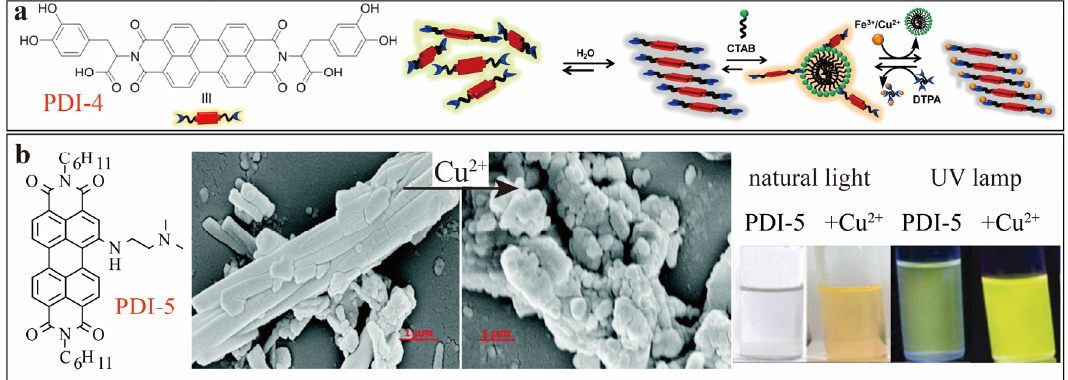
Figure 3. ( a ) Schematic illustration of CTAB and metal ions induced assembly-disassembly process of PDI-4. Reproduced with permission from [10], copyright 2014 American Chemical Society. ( b ) Molecular structures of PDI-5, and the SEM images of their self-assemblies from (10 µM) ACN solution before and after adding Cu(ClO 4 ) 2 , as well as photos of color change of 25 µM PDI-5 in ACN under natural light or UV lamp ( λ ex = 365 nm) before and after adding 250 µM Cu 2+ . Reproduced with permission from [11], copyright 2016 Royal Society of Chemistry.